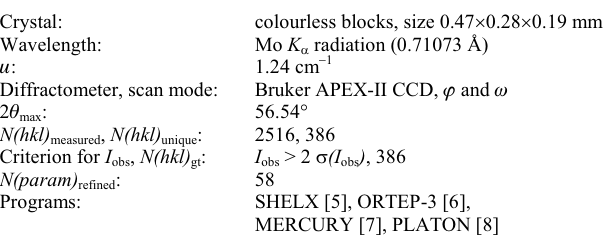
Table 1. Data collection and handling.